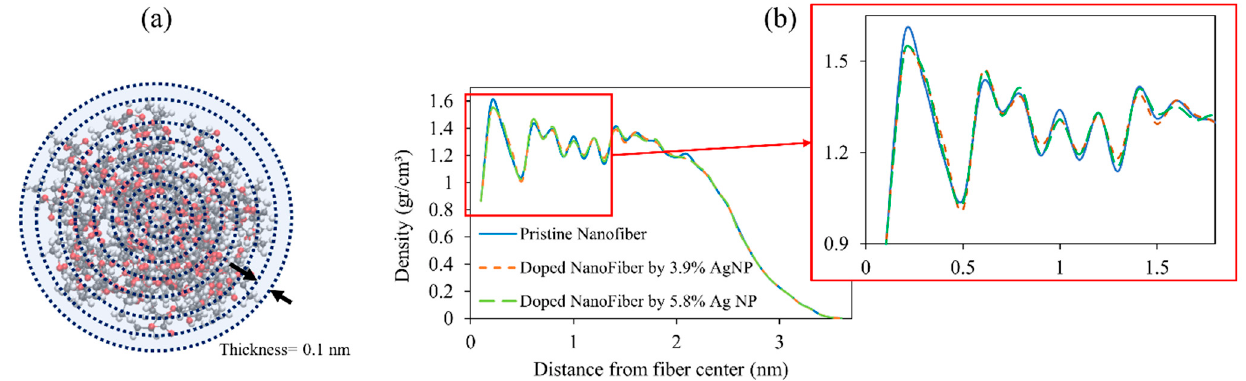
Figure 12. ( a ) The schematic of nanofibre cross-sections divided into concentric cylindrical shells of 0.1 nm thickness. ( b ) Distribution of radial mass density of pristine and doped nanofibres.